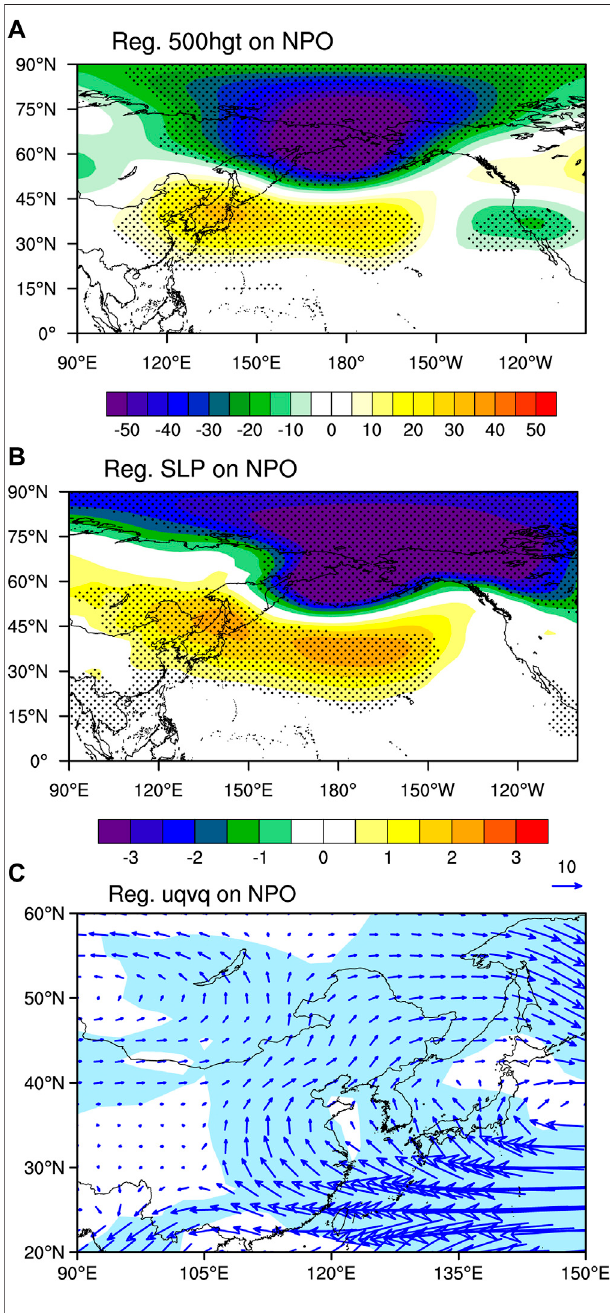
FIGURE 7 | Regression of (A) 500-hPa HGT (unit: gpm), (B) SLP (unit: hPa), and (C) vertically integrated WVT (unit: kg m − 1 s − 1 ) on the NPO index for November during 1979 – 2019. Regions above the 90% signi fi cance level are dotted in (A,B) and shaded in (C) .